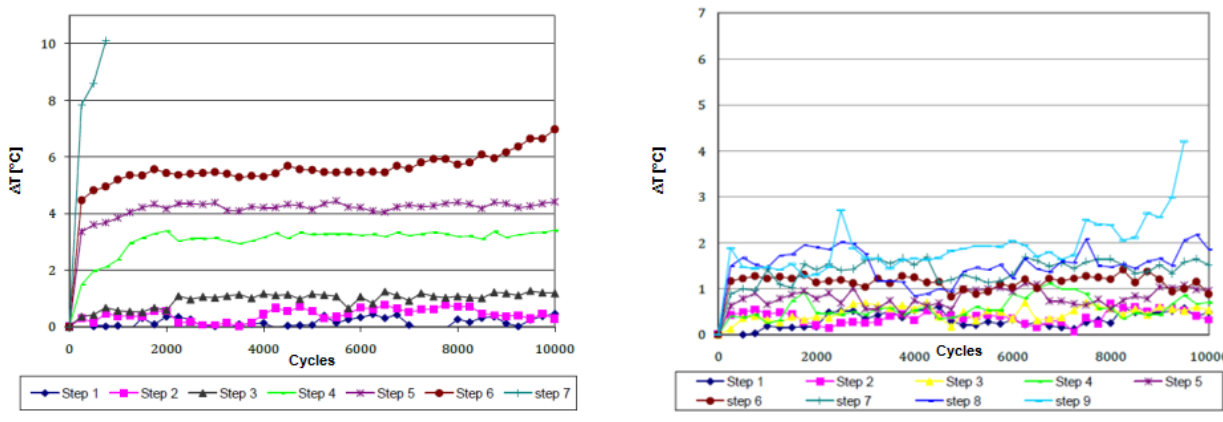
Figure 15: Thermal map of the specimen 3. Figure 16: Thermal map of the specimen